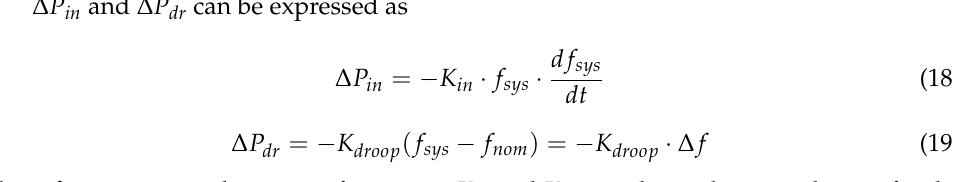
Figure 7. Structure of the proposed inertial control scheme. 3.3.1. Determining Control Coefficient for Inertial Response Imitation Period Under various sizes of disturbance, a control coefficient should be determined that is suitable for the power deficit to improve the frequency support capability. Thus, to en- hance the frequency support capability while avoiding the stalling of the DFIG, the control coefficient for the inertial response imitation period can be expressed as: sup